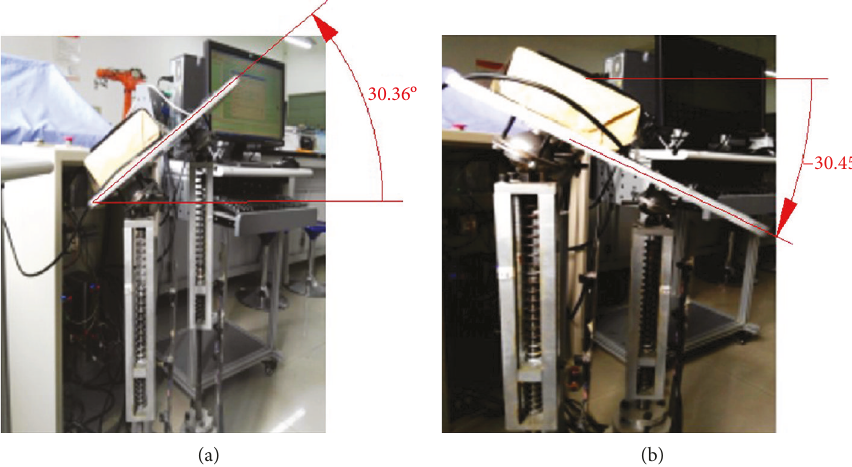
Figure 21: The maximum working angles for the varus/valgus rehabilitation motion: (a) move up and (b) move down.